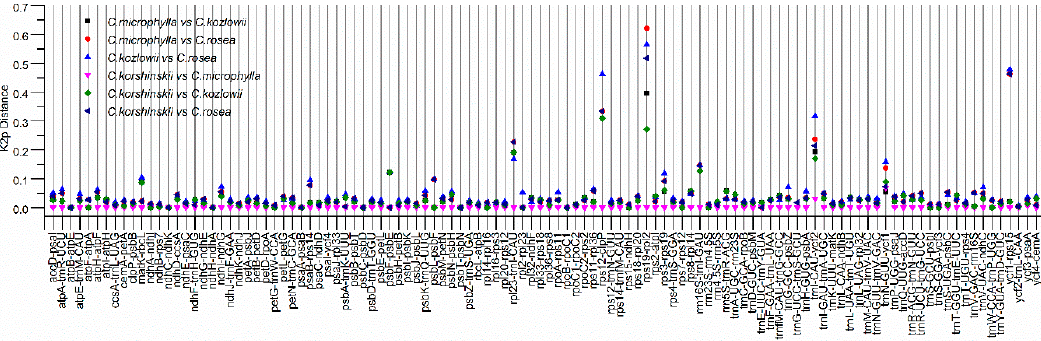
Figure 5. K2p distances for IGS regions among C. rosea , C. microphylla , C. kozlowii , and C. korshinskii .